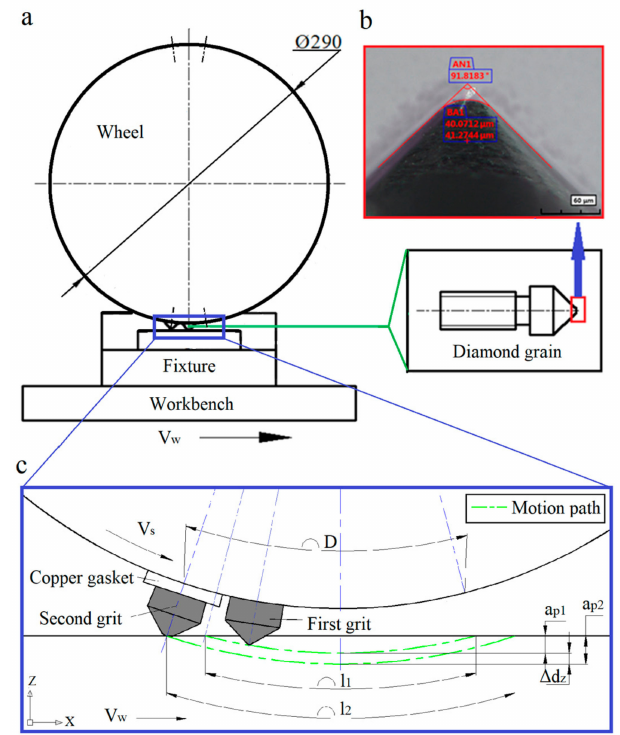
Figure 1. Schematic diagram of twice scratching experimental devices, ( a ) experimental device of two grits scratching, ( b ) detail size of the diamond grain, and ( c ) diagram of interference of twice scratching.